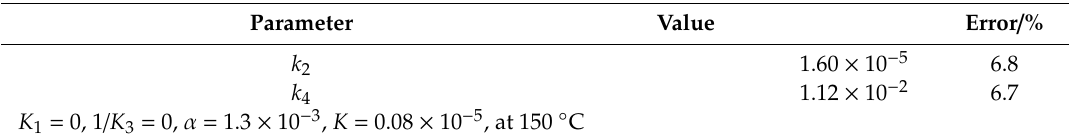
Table 3. Parameter estimation